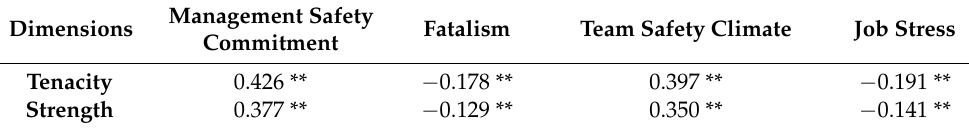
Table 8. Correlation coefficients between resilience and safety behavior. Dimensions